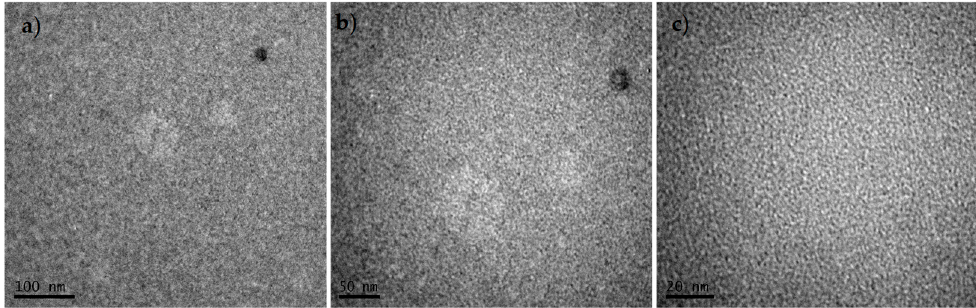
Figure 13. TEM images of P3,6C(EH)DTBT-(P5FQ-(P5FQ-N-PC 61 BM)). The scale bars correspond to 100, 50 and 20 nm for figures ( a ), ( b ) and ( c ), respectively.